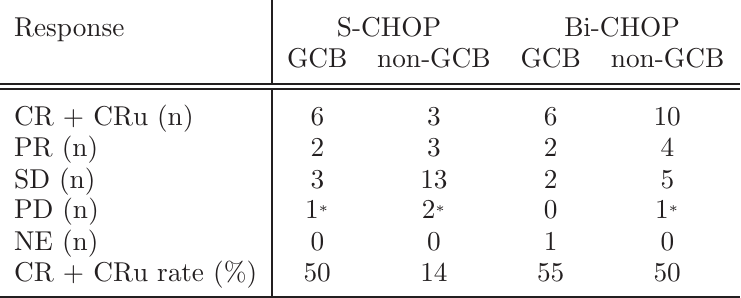
Table 3 Clinical response to and evolution after biweekly CHOP or standard-dose